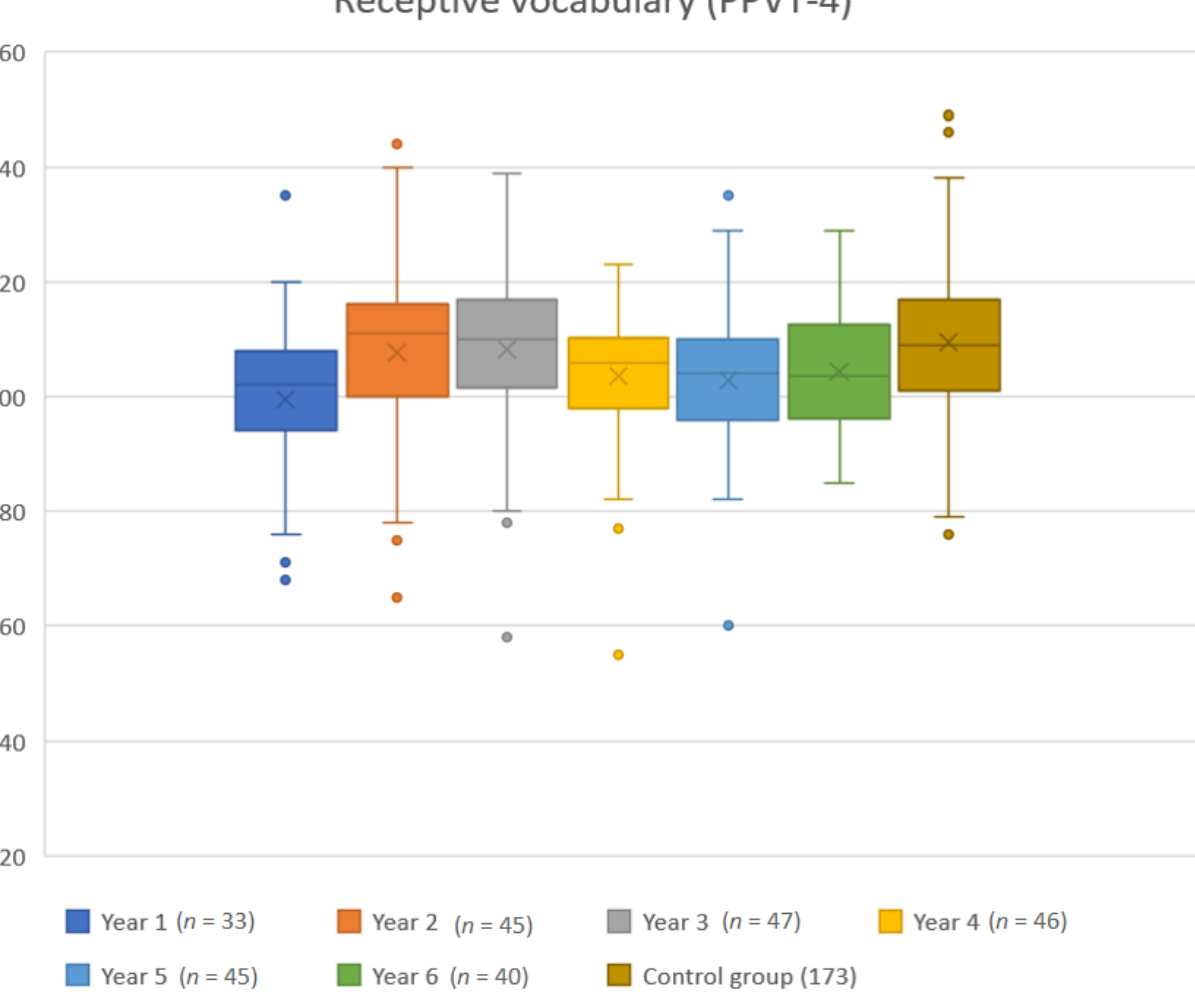
Figure 1. Annual standard scores of children with HI as compared to the control group of children with NH. Dots are outliers. Mean standard score according to the American norm is 100 and standard deviation is 15.